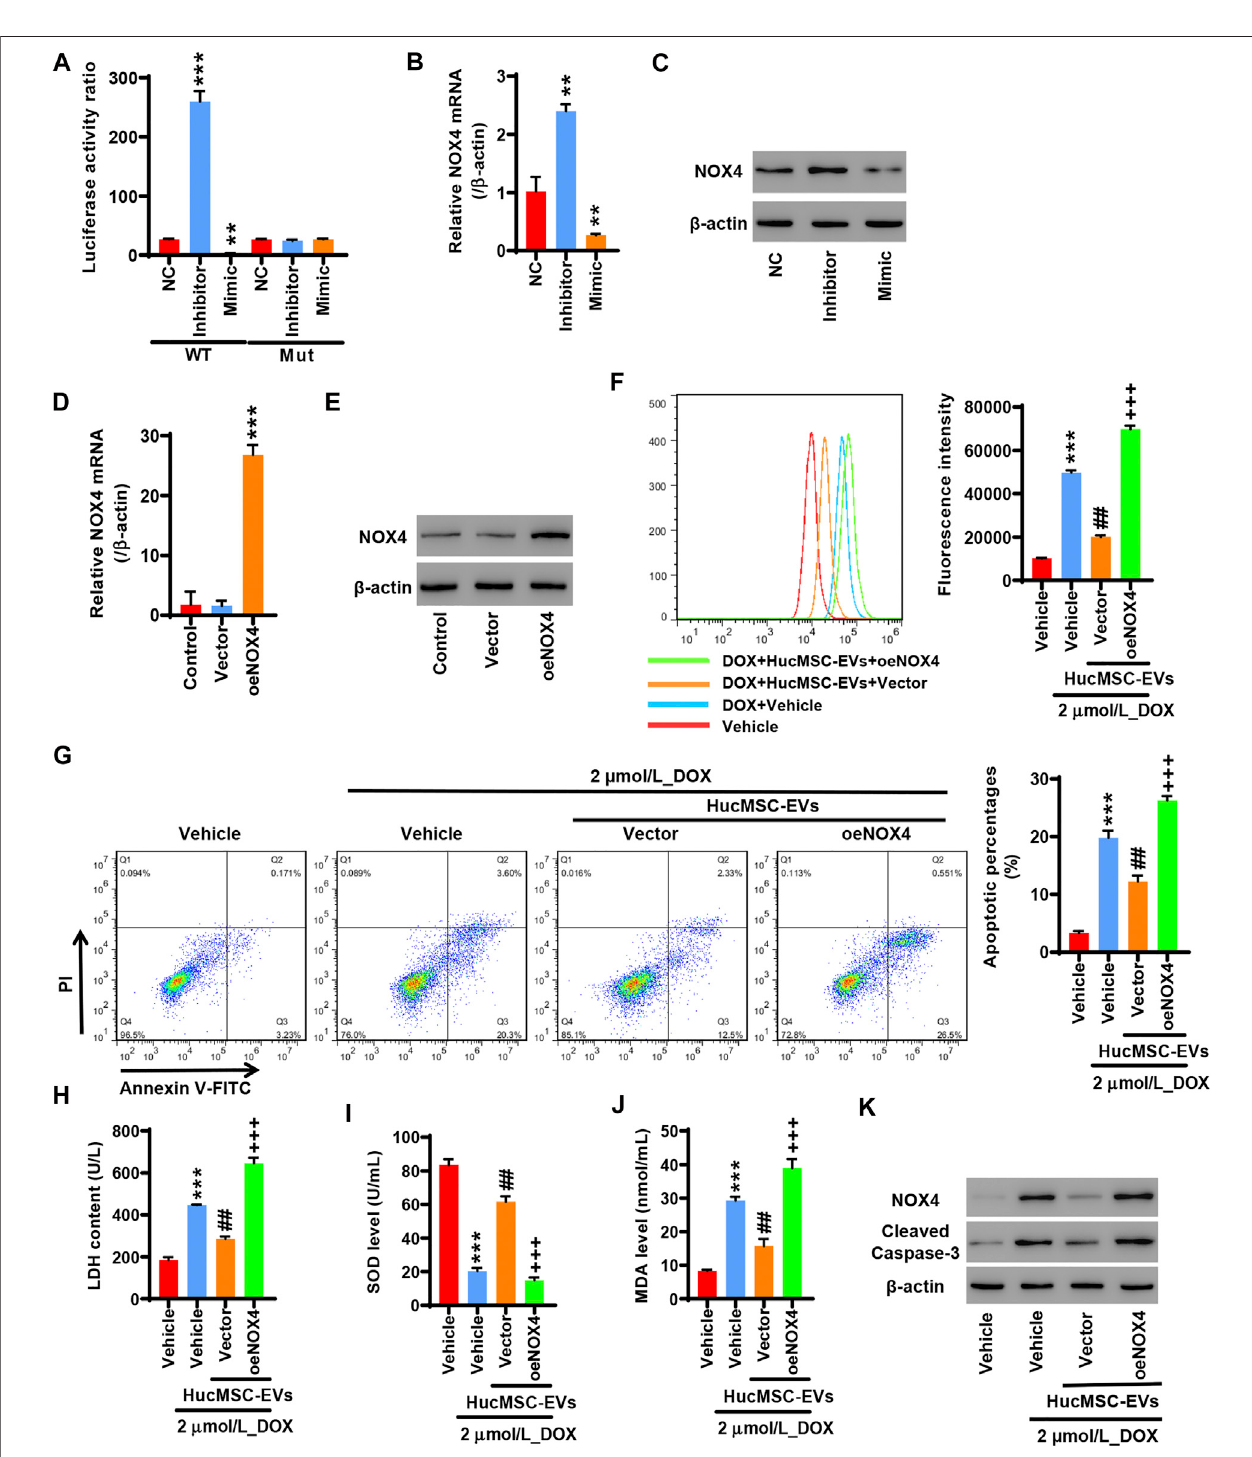
FIGURE 5 | Overexpression of NOX4 abolishes those effects in which HucMSC-EVs inhibit DOX-induced oxidative stress and apoptosis. 293T cells were co- transfected with either pGL3-NOX4-WT, miR-100-5p inhibitor (Inhibitor)and miR-100-5p Mimic, and pGL3-NOX4-MUT, mimic (Mimic) or pGL3-NOX4-MUT, miR-100- 5p inhibitor (Inhibitor) and miR-100-5p mimic (Mimic). (A) Luciferase activity was quanti fi ed using a luminometer. ** p < 0.01, *** p < 0.001 vs. WT + NC. (B) NOX4 mRNA was examined by qRT-PCR. (C) NOX4 protein expression was detected by Western blot. ** p < 0.01 vs. NC. (D) AC16 cells were transfected with oeNOX4. NOX4 mRNAwasexaminedbyqRT-PCR. (E) AC16cellsweretransfectedwithoeNOX4.NOX4proteinwasdetectedbyWesternblot. *** p < 0.001vs.vector. (F – K) AC16cells weretransfectedwithoeNOX4for24 handthentreatedwith2 µmol/LDOXand100 µg/mlHucMSC-EVsfor24 h. (F) ROSlevelsweremeasuredby fl owcytometry. (G) Apoptosis was measured by fl ow cytometry. Quadrant 1 represented dead cells. Quadrant 2 represented late apoptotic cells. Quadrant 3 represented early apoptotic cells, and Quadrant 4 represented normal cells. LDH (H) , SOD (I) , and MDA (J) were measured by biochemical assay. (K) NOX4 and cleaved-caspase-3 expression were determined by Western blot. *** p < 0.001 vs. vehicle, ## p < 0.01 vs. 2 μ mol/L_DOX + vehicle, +++ p < 0.001 vs. 2 µmol/L_DOX + HucMSC-EVs + vector.